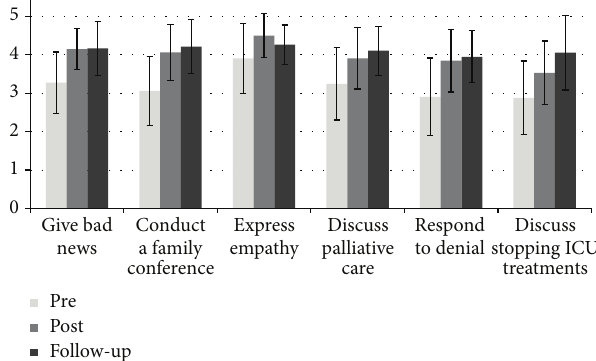
Figure 1: Resident self-assessed preparedness prior to the interven- tion( 𝑛 = 38 ),aftertheintervention( 𝑛 = 32 ),andat9-monthfollow- up ( 𝑛 = 18 ). All 𝑝 < 0.05 except “expressing empathy” at follow-up ( 𝑝 = 0.12 ). Error bars show standard deviation. ICU, intensive care